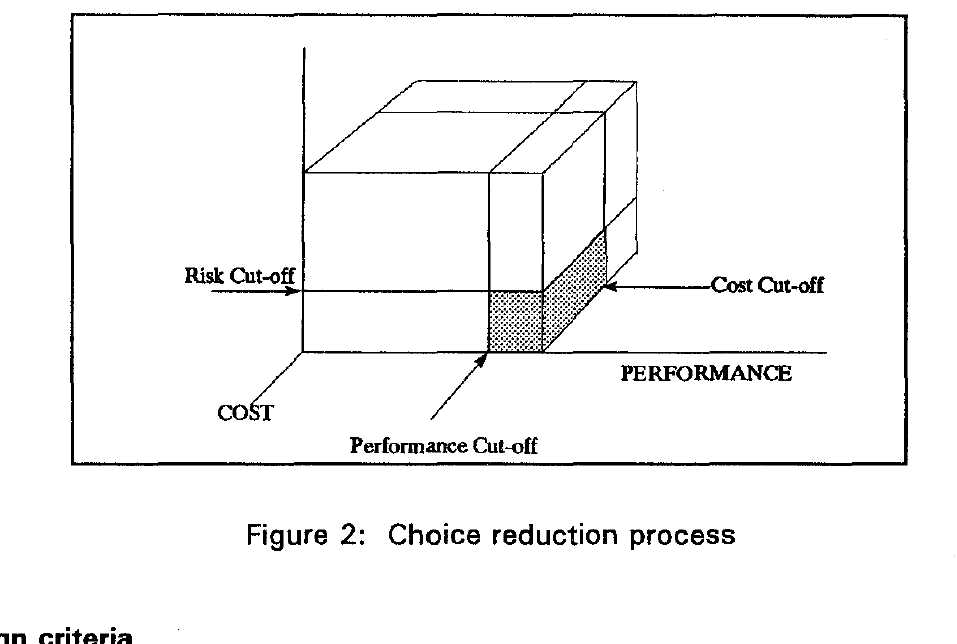
Figure 2: Choice reduction